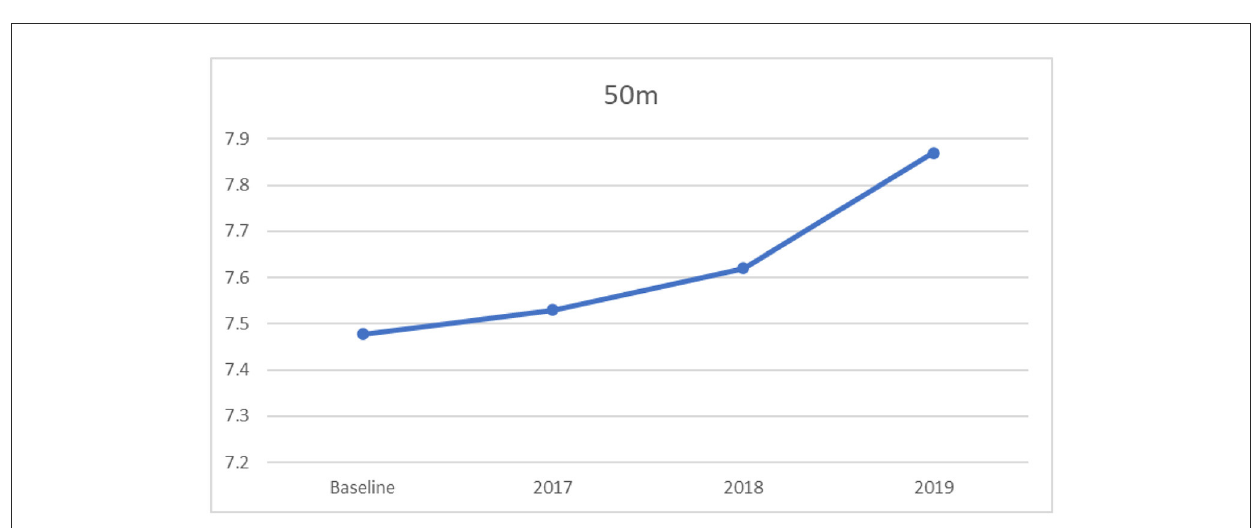
FIGURE2 Mean 50m sprint scores: across baseline and years 2017–2019.